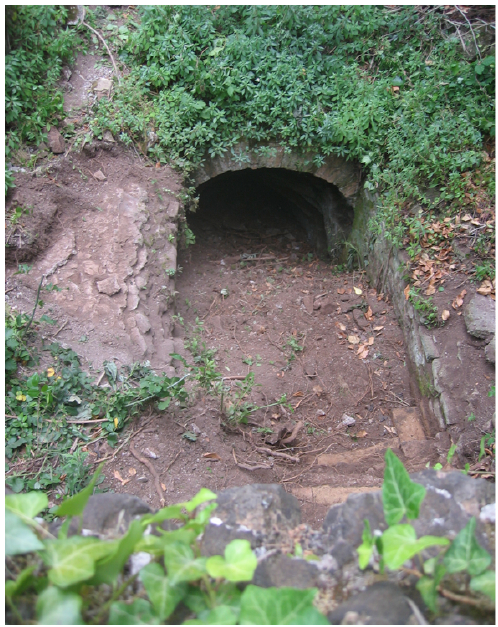
Fig. 5. The stair F descending to the subterranean tunnel C (photo M. De